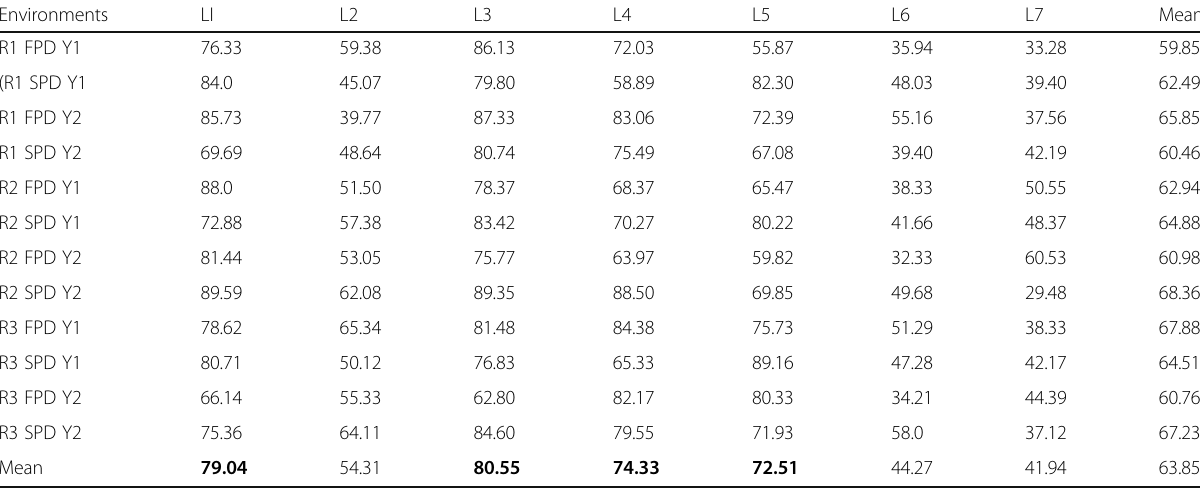
Table 9 The mean values for the seven rice entries under the 12 environments for grain yield/plant